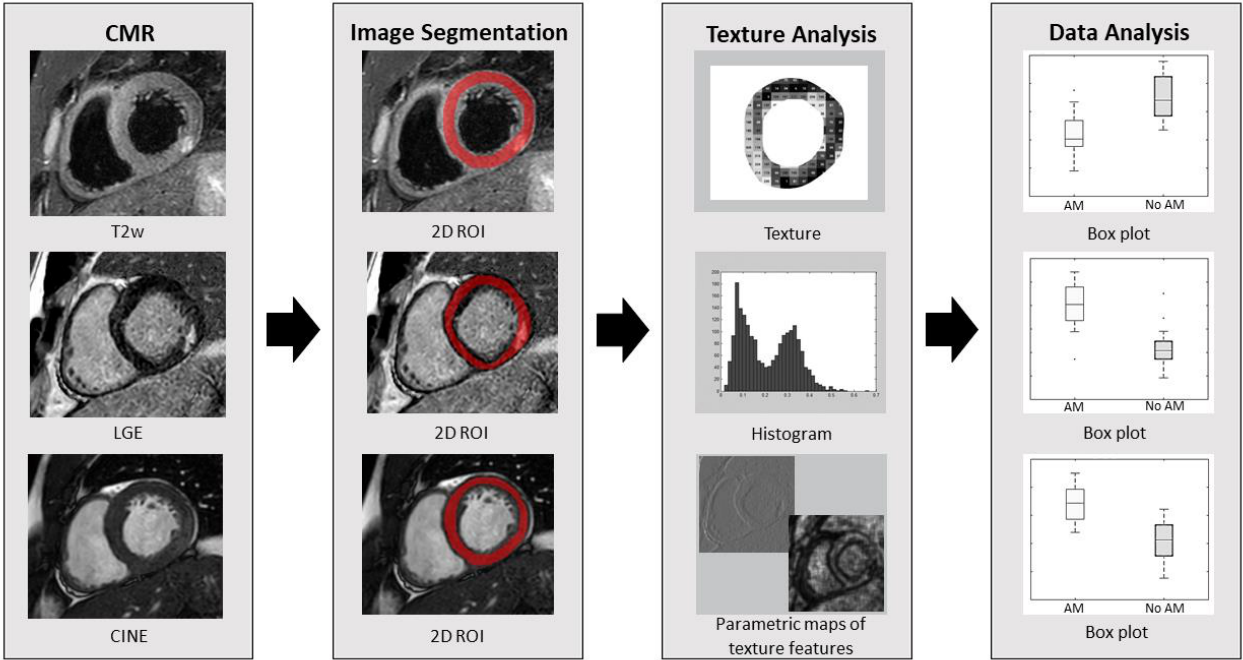
Figure 1. Schematic illustration of the workflow of the study, including the texture analysis. In a cohort of patients with suspected acute myocarditis (AM), texture features were extracted from con- ventional cardiac magnetic resonance (CMR) images, including T2-weighted (T2w), late gadolinium enhancement (LGE) and CINE images, using predefined myocardial region of interests (2D ROI). Extracted features were compared between patients with and without CMR-verified AM.